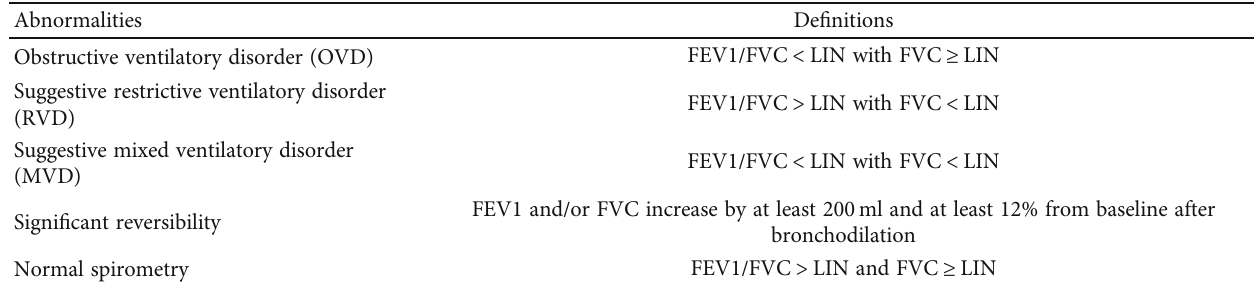
Table 1: De fi nition criterion of lung function disorders adapted from ATS/ERS